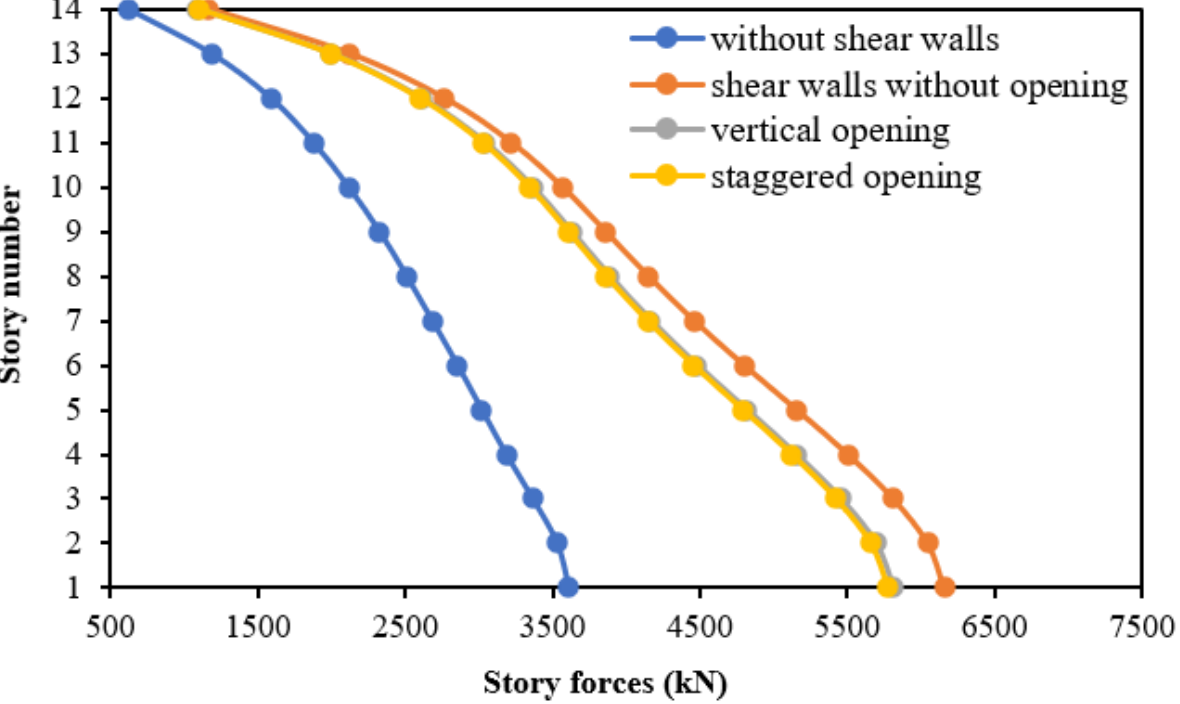
Figure 20. Story forces of the models, response spectrum analysis, Y-direction.